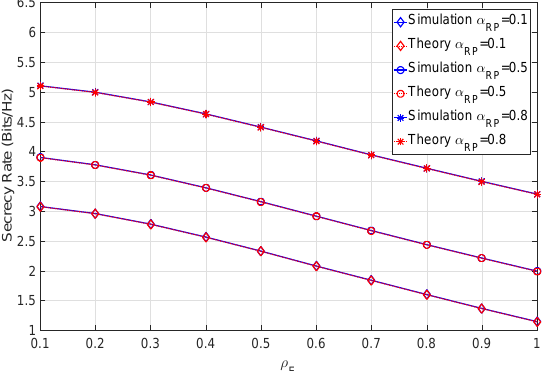
Figure 12. Secrecy rate of the system for various ray power ratios with β N = 100 at 12 dB SNR.